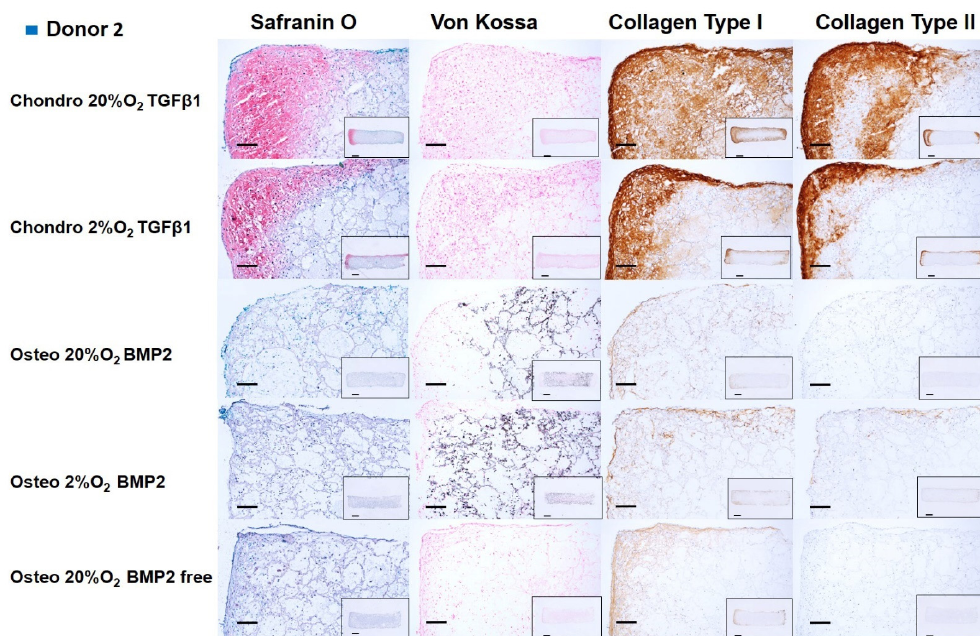
Figure 7. Chondrogenic and osteogenic hBMSC-constructs after 2 weeks of culture. Images showing a higher magnification of donor 2. Scale bar: 200 μ m. Inset: Images showing the full section of the constructs 1. Scale bar: 1 mm. Scaffolds were stained with safranin O/Fast Green, Von Kossa and immunohistochemically labelled for collagen type I and collagen type II. Chondrogenically differentiated groups showed higher Safranin O, Collagen Type I and Collagen type II deposition. The osteogenically differentiated groups with BMP2 are positive for Von Kossa staining.